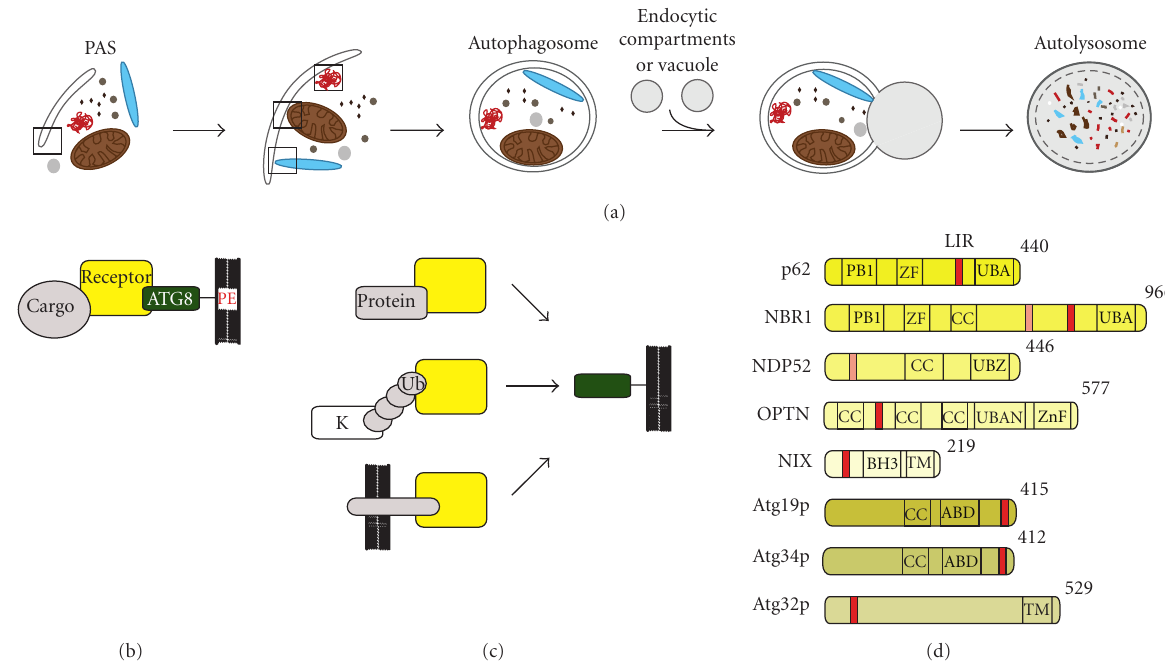
Figure 1: (a) Overview of selective autophagy. Boxes indicate localization of ATG8 and autophagy receptor proteins. (b) Scheme of autophagy receptor function. (c) Di ff erent cargo-binding concepts of autophagy receptors. (d) Domain architecture of the known characterized autophagy